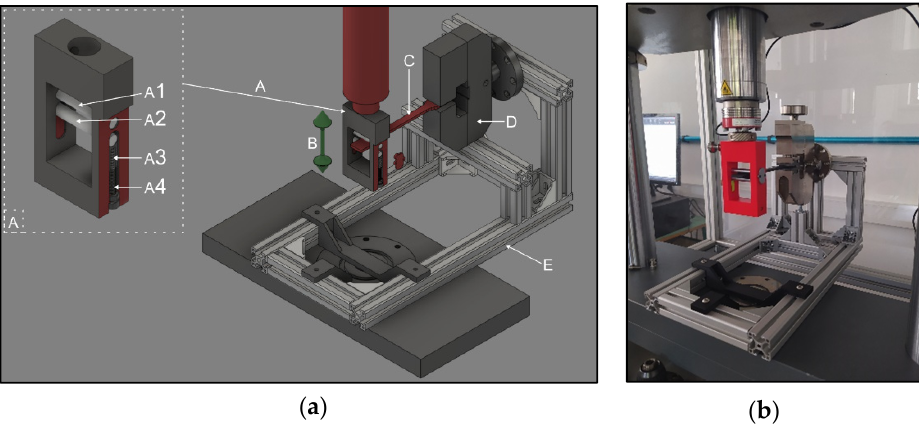
Figure 1. ( a ) The models used in the setup of the flexural fatigue test measurement. ( A ) Special gripper; ( A 1 ) fixed roller; ( A 2 ) moving roller; ( A 3 ) spring; ( A 4 ) adjusting screw; ( B ) moving direction; ( C ) specimen; ( D ) screw grip; ( E ) support frame. ( b ) The assembled device for the flexural fatigue test measurement.